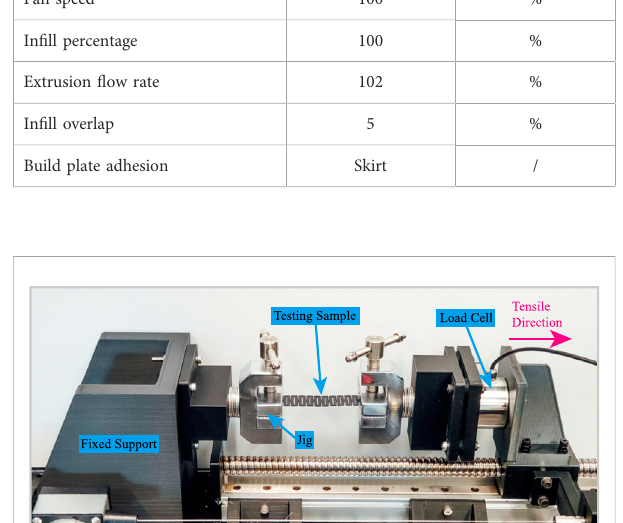
Figure 2. The deformation ratio of the kirigami-inspired elastic spring will be determined in this section. There are two boundary deformation ratios: λ min and λ max . Though the actual deformation ratio of spring λ could not be determined kinematically for different materials and structures, it should be within these two boundary deformation ratios.